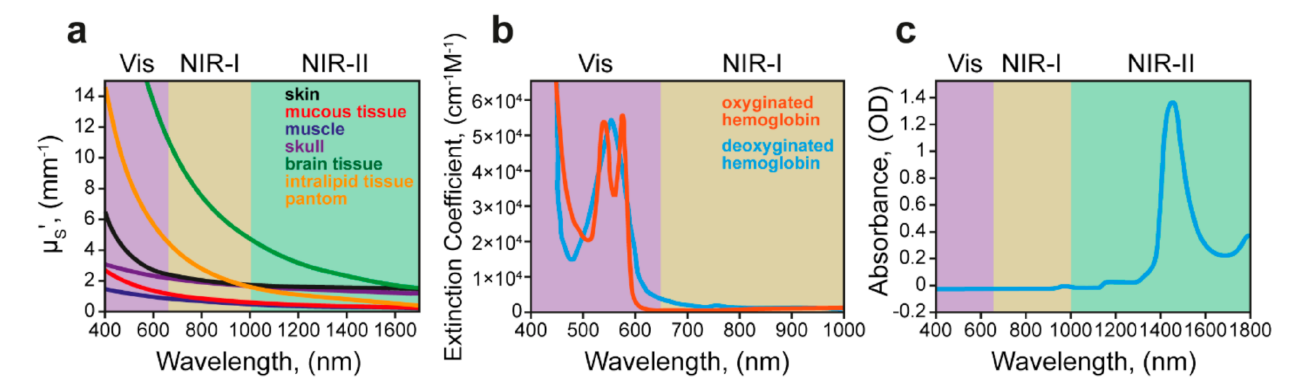
Figure 7. ( a ) The reduced scattering coefficient, µ s (cid:48) , in the range of 400–1700 nm for various tissue types including the skin (black), the mucous tissue (red), muscle (blue), skull (violet), the brain tissue (green), and the tissue phantom, Intralipid (orange). The plots for skin, mucous tissue, muscle, and skull are derived from human samples, while that for the brain is derived from mouse samples. ( b ) Absorption spectra of oxygenated hemoglobin (orange) and deoxygenated hemoglobin (blue) in the range of 400–1000 nm, showing minimum absorbance beyond 650 nm. ( c ) The absorption spectrum of water (H 2 O) in a cuvette with a 1 mm path length, featuring strong vibrational overtone absorption bands in the 1400–1500 nm region and the >1700 nm region. Adapted with permission from [148]. Copyright 2015, American Chemical